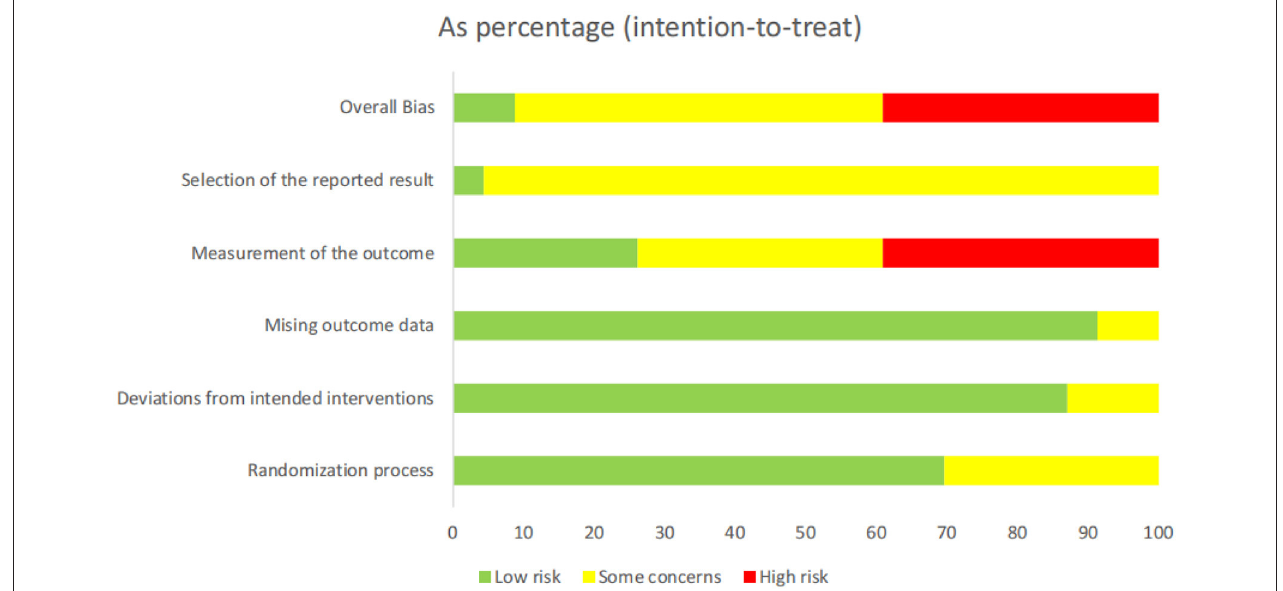
FIGURE 2 | Risk of bias summary: review authors’ judgement regarding each risk of bias item for each included